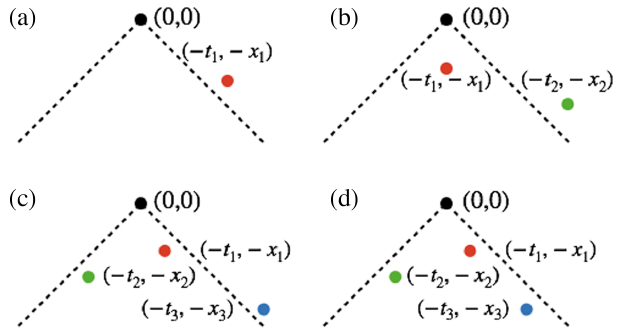
FIG. 8. (a) – (c) illustrate three possible cases in which the spacetime points ð − t 1 ; − x 1 Þ (red dot), ð − t 2 ; − x 2 Þ (green dot), ð − t ; − x Þ (blue dot) lie outside of the past light cone (dashed 3 3 line) of the origin (black dot). In any of the three cases, the response function G R [Eq. (8)] vanishes. (d) Causality requires that all three points lie inside the past light cone of the origin to induce a nonzero